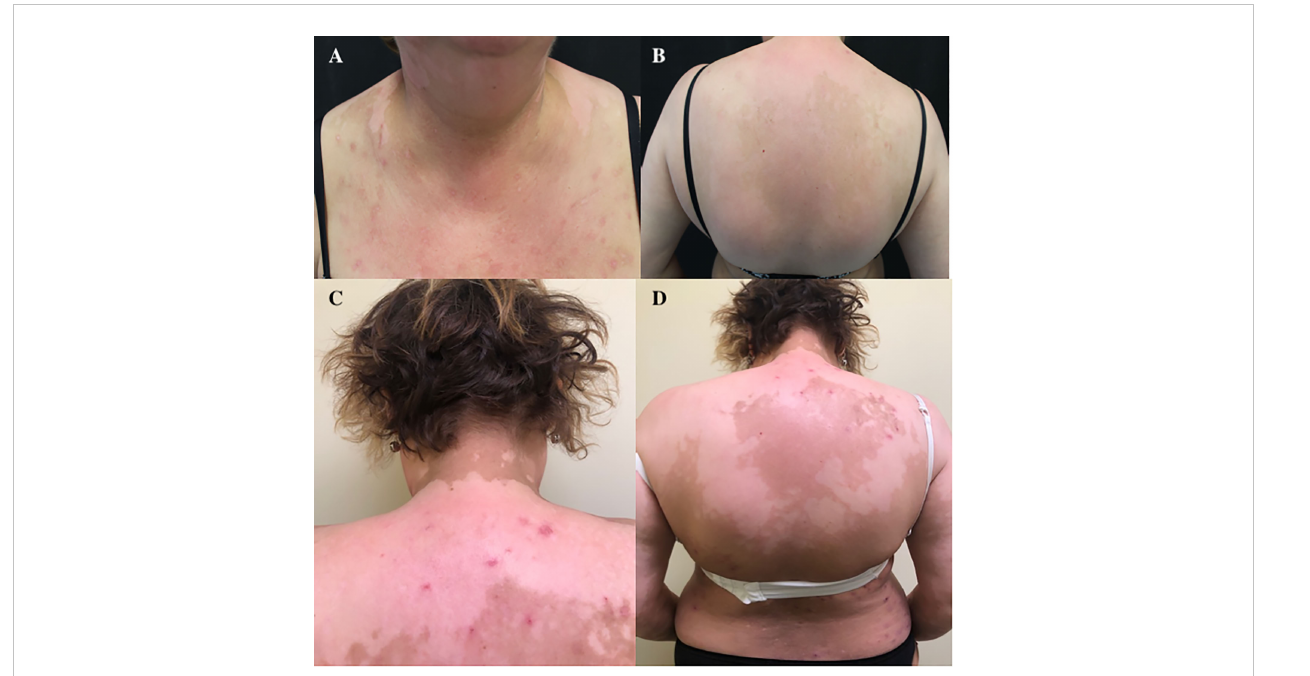
FIGURE 1 (A) Erythematous-vesicular cutaneous rash after 3 months of therapy with ribociclib. (B – D) Residual depigmented areas of the